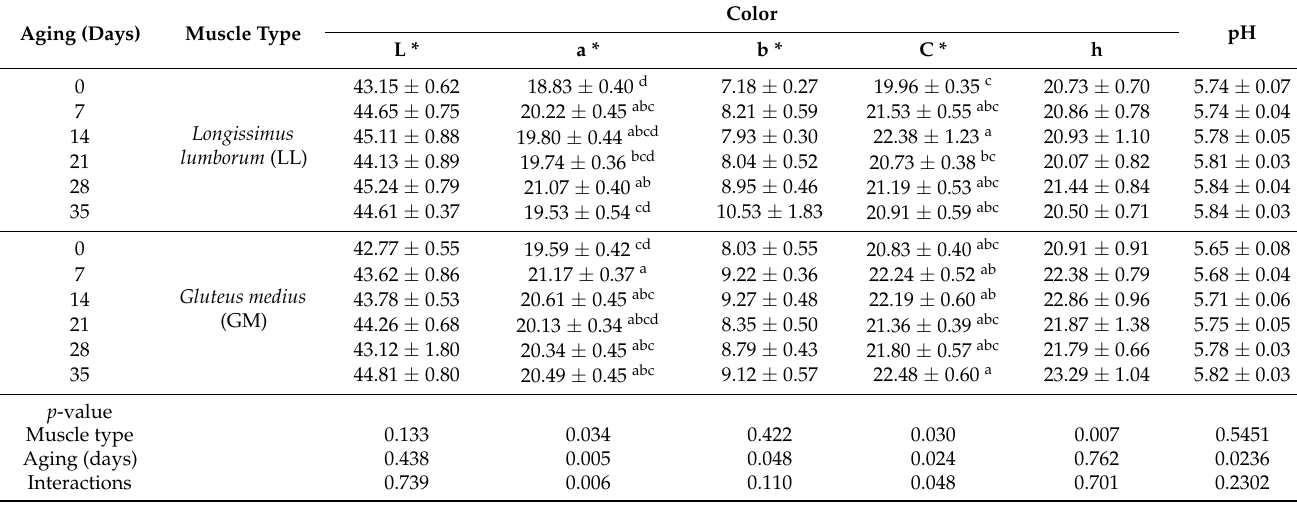
Table 1. Effects of aging time and muscle type on instrumental color (CIE L *, a *, b *, C *, h) and pH values of buffalo meat. Aging (Days) Muscle